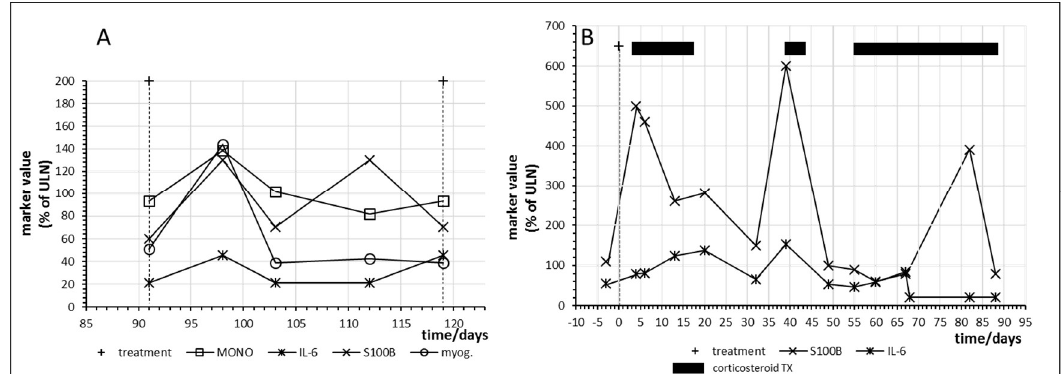
Figure 7. Time course of immune, tumor and cell damage (myoglobin (myog.)) markers during checkpoint inhibitor treatment starting at day 0. ( A ) Patient no. 15, fourth cycle of nivolumab; ( B ) Patient no. 16, first cycle of nivolumab plus ipilimumab combination treatment. MONO = monocytes.